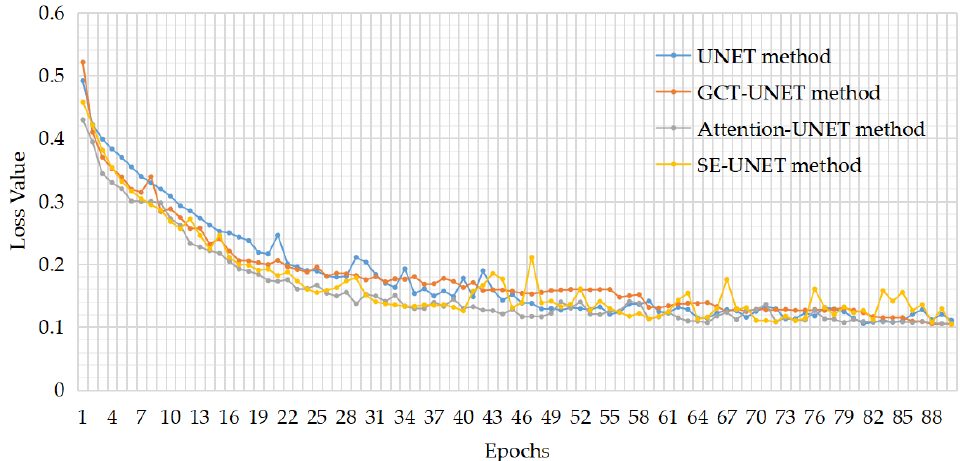
Figure 3. Validation set loss decline curves for different model